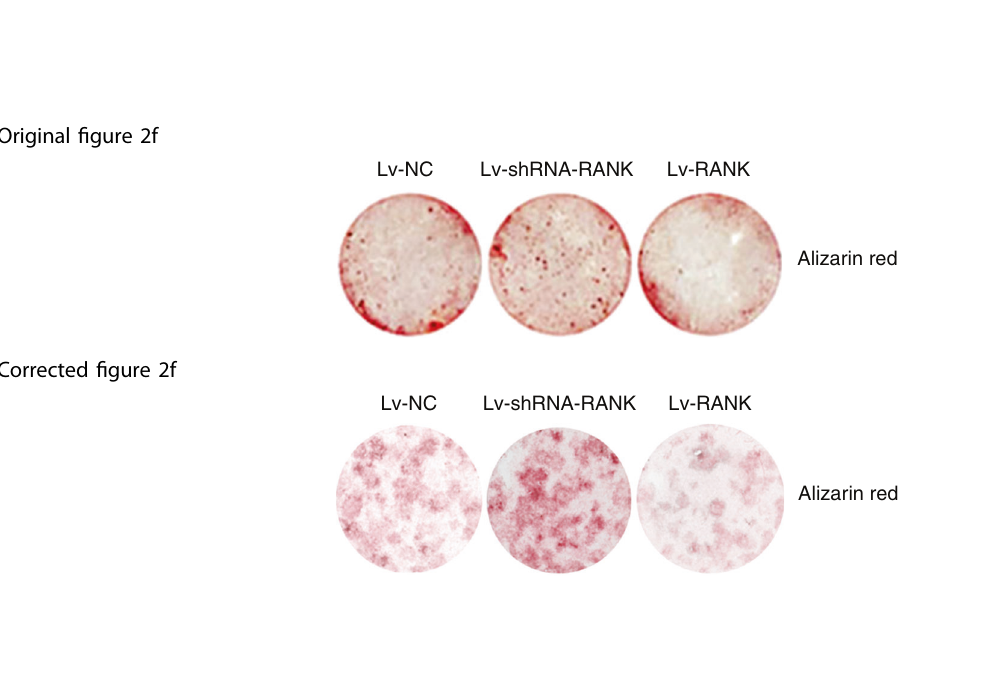
The correct Figure legend for Figure S5 should be: Figure S5. RANK overexpression and silence. (a) fl uorescence of BMSCs infected with lentivirus. 1 and 2 showed fl uorescence of BMSCs infected with lentivirus-NC after 60 h while 3 and 4 showed BMSCs infected with lentivirus-NC after 72 h to examine the infection rate. MOI = 20. Scale bar = 100 μ m. (b) PCR quanti fi cation analysis of rank expressions. (c) Western blot analysis of RANK expressions. Data represent the mean ± SEM ( n = 8). * P < 0.05, ** P <